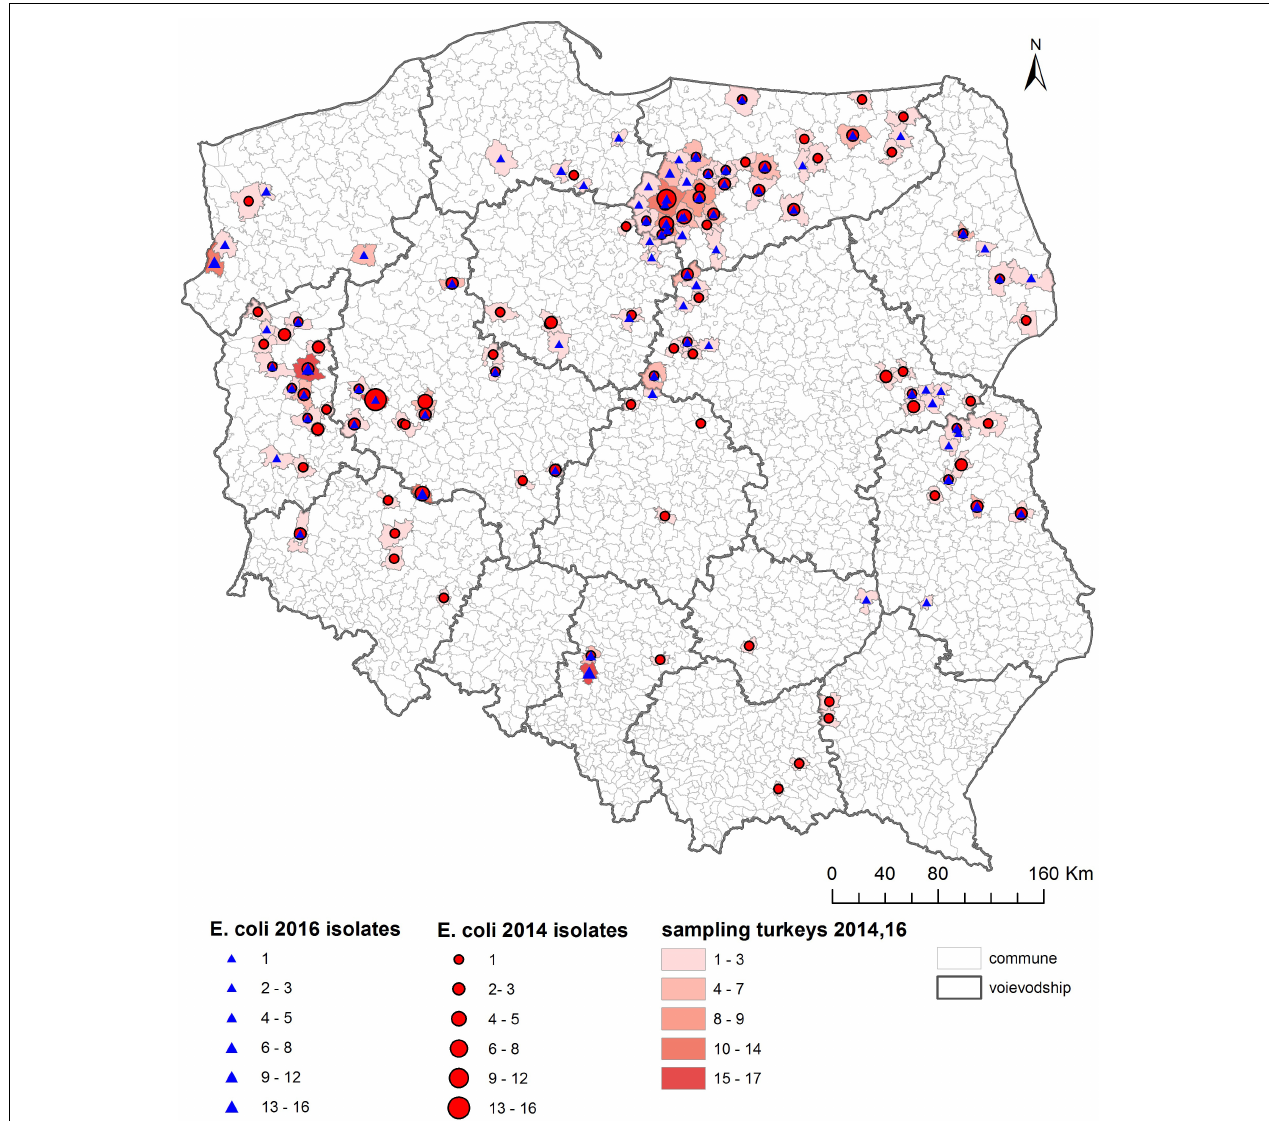
FIGURE 4 | Geographical distribution (commune level) of turkey sampling. Single turkey caeca was collected at slaughter and farm of origin was retrieved for verification of randomization of samples used for isolation of indicator E. coli in 2014 and 2016.